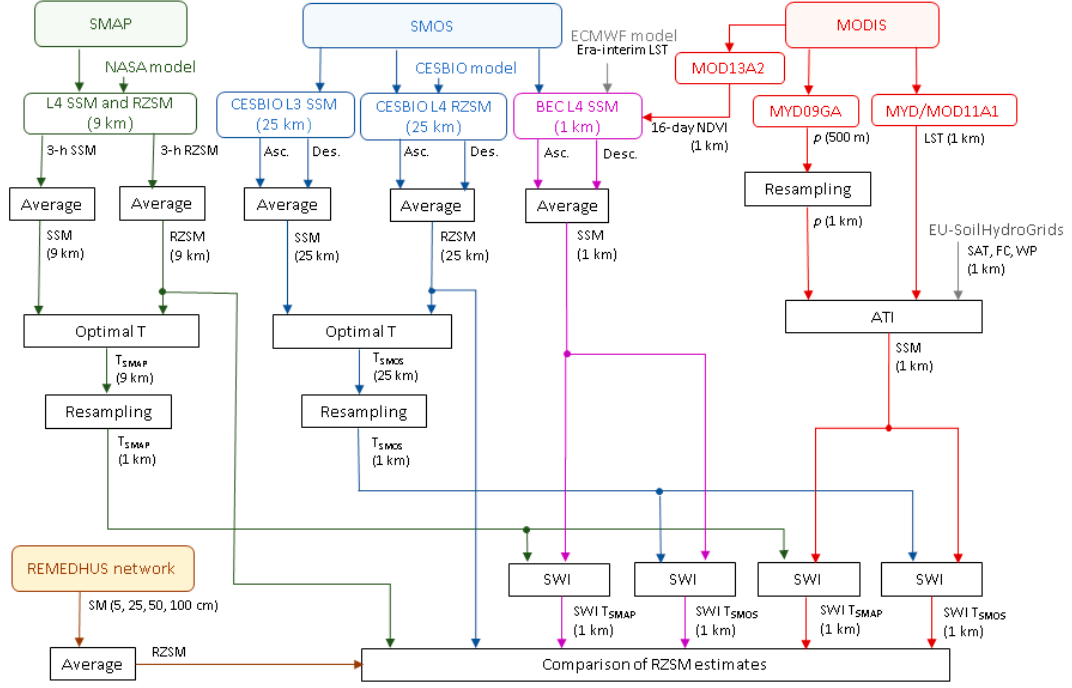
Figure 1. Flowchart showing all data and methodology applied to obtain the RZSM estimates.